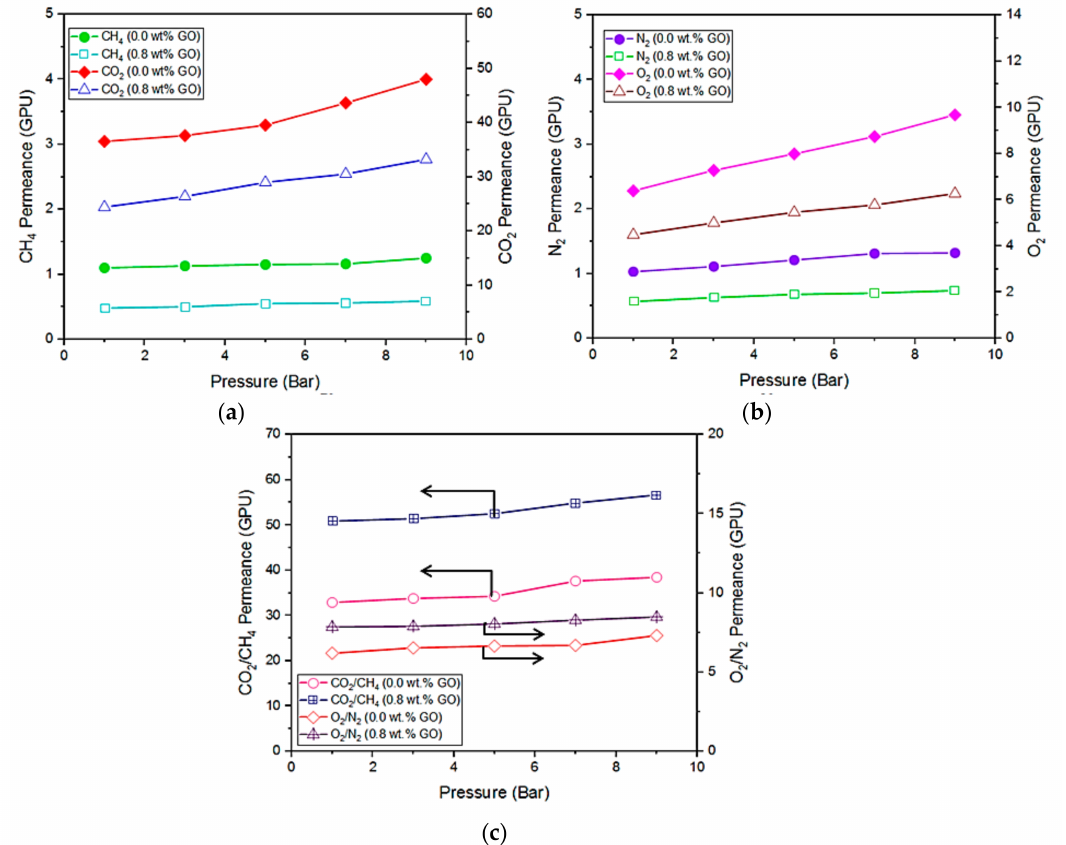
Figure 9. E ff ect of feed pressure on ( a ) CO 2 , CH 4 , and ( b ) O 2 , N 2 gas permeance of 0.0 wt% and 0.8 wt% GO and their respective gas pair selectivity ( c